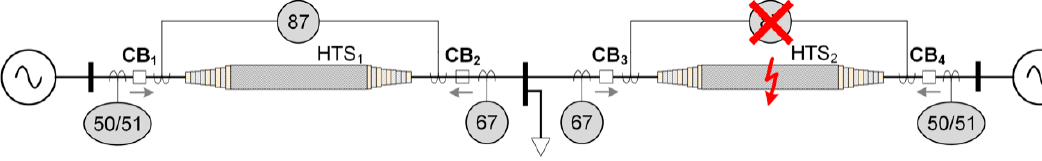
Figure 16. Tested system in case of DCR failure.